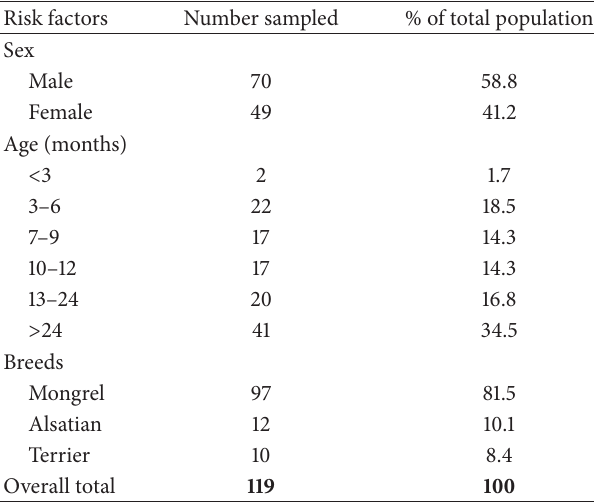
Table 2: Prevalence of Salmonella among exotic and local breeds of dogs according to sex, age, and breeds in Maiduguri, Nigeria ( 𝑛 = 119